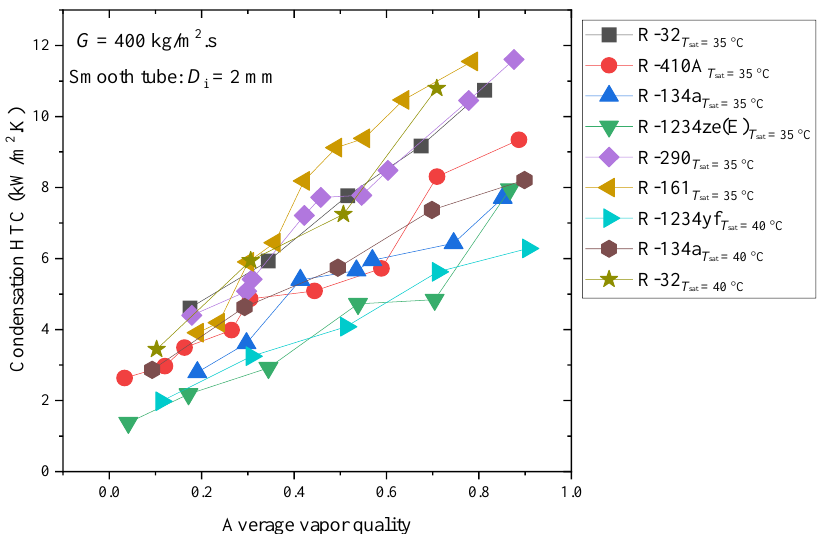
Figure 8. Condensation HTC of various refrigerants inside a 2 mm smooth tube. Triangular forward, hexagonal, and star solid connected line presents the Wang et al. [24] study, and the remaining symbols presents the Guo et al. [19] study.